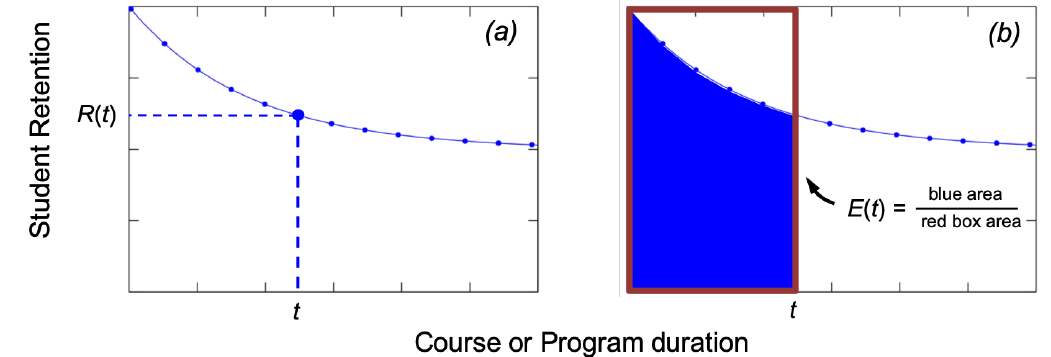
The Difference Between R(t) and E(t) Shown Graphically